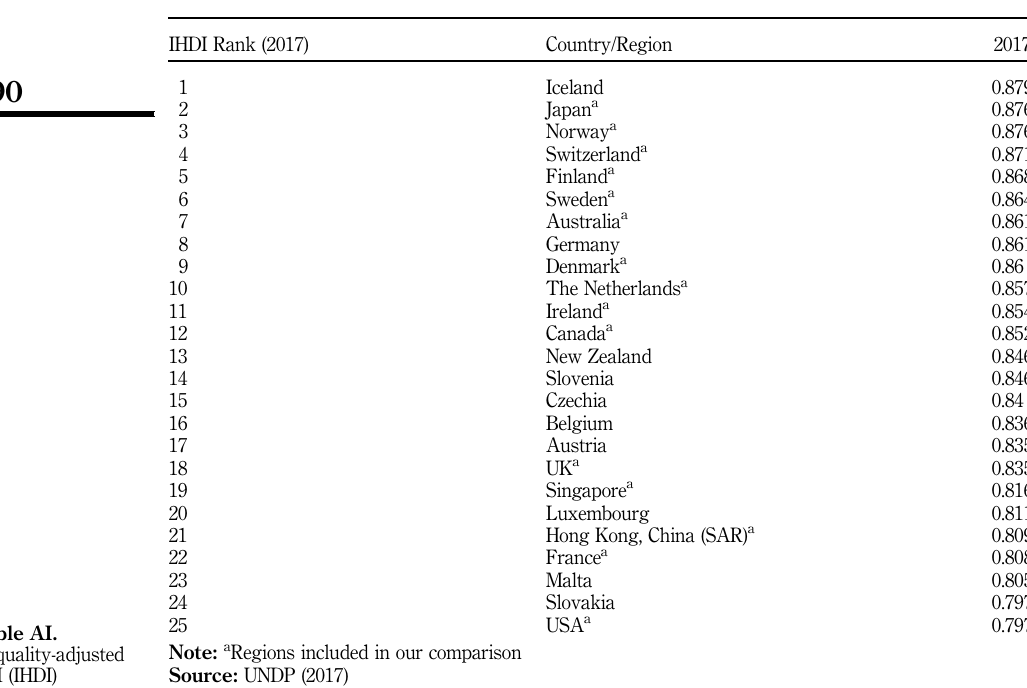
Table AI. Inequality-adjusted HDI